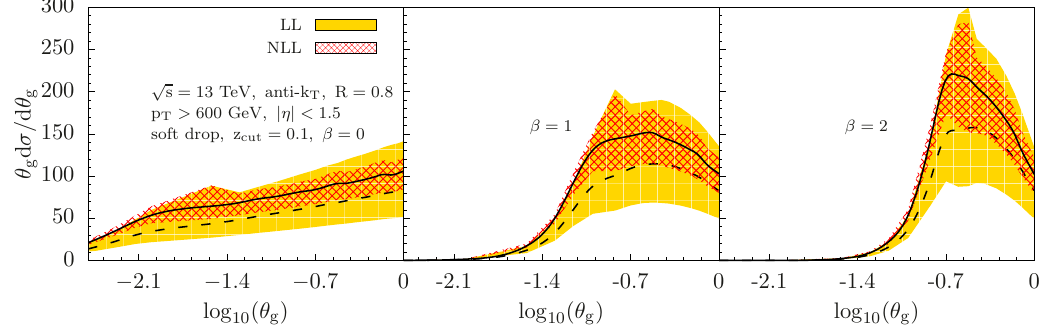
Figure 5 . A comparison between the LL and NLL 0 predictions for the (cid:18) g distribution. Signi(cid:12)cant reductions in the theoretical uncertainties are observed for all (cid:12) choices for the NLL 0 results as compared with the LL